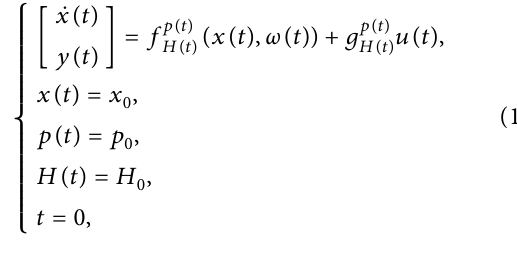
The right-continuous hidden Markov chain H ( t ) is ( t ) in the finite set M : composed of the hidden state h 1